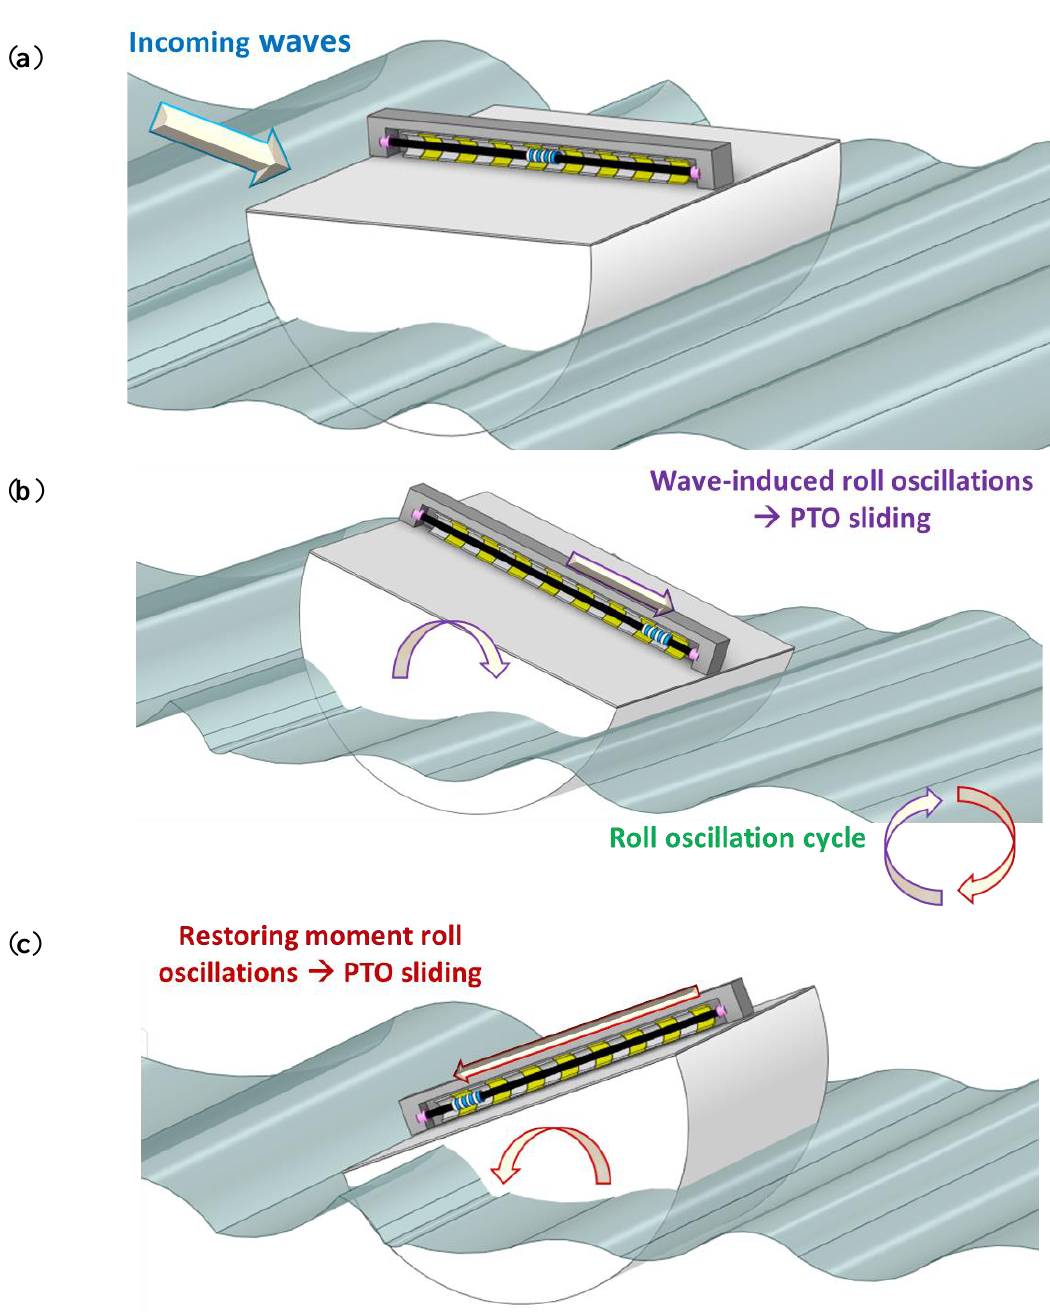
Figure 2. E-Motions operation at sea, under wave action: ( a ) initial equilibrium state; ( b ) wave- induced roll oscillations and translation of the PTO along the superstructure; ( c ) restoring moment induced roll oscillations and PTO sliding towards the superstructure’s end-stop at a lower height.